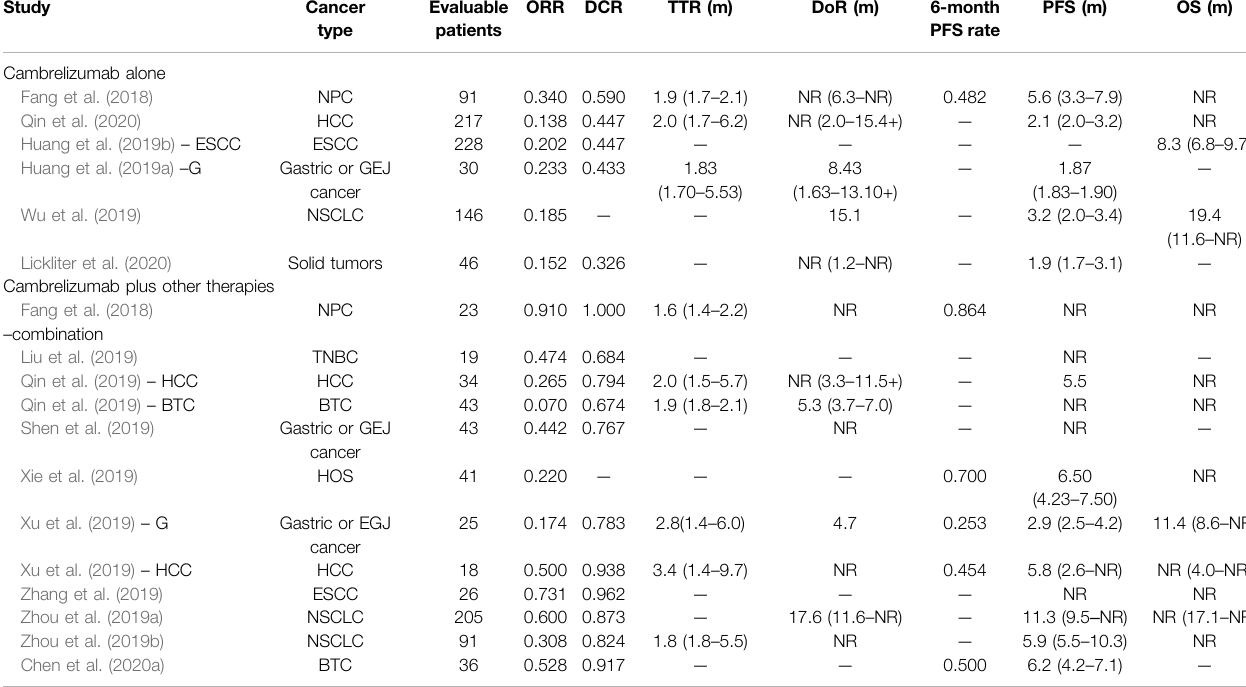
DCR,diseasecontrolrate;DoR,durationofresponse;m,month;NR,notreached;ORR,overallresponserate;OS,overallsurvival;PFS,progression-freesurvival;TTR,timetoresponse; NPC,nasopharyngealcarcinoma;HCC,hepatocellularcarcinoma;ESCC,esophagealsquamouscellcarcinoma;NSCLC,non-smallcelllungcancer;BTC,biliarytractcancer;HOS,high- grade